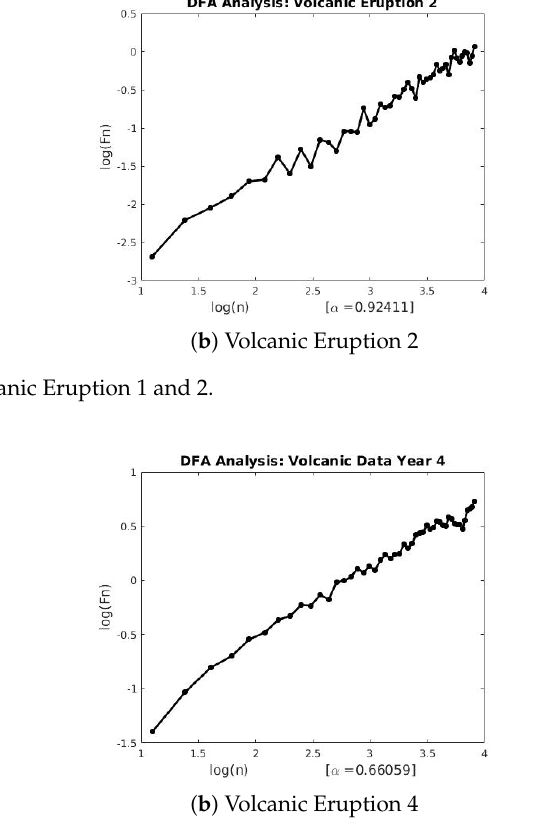
Figure A12. DFA for Volcanic Eruption 3 and